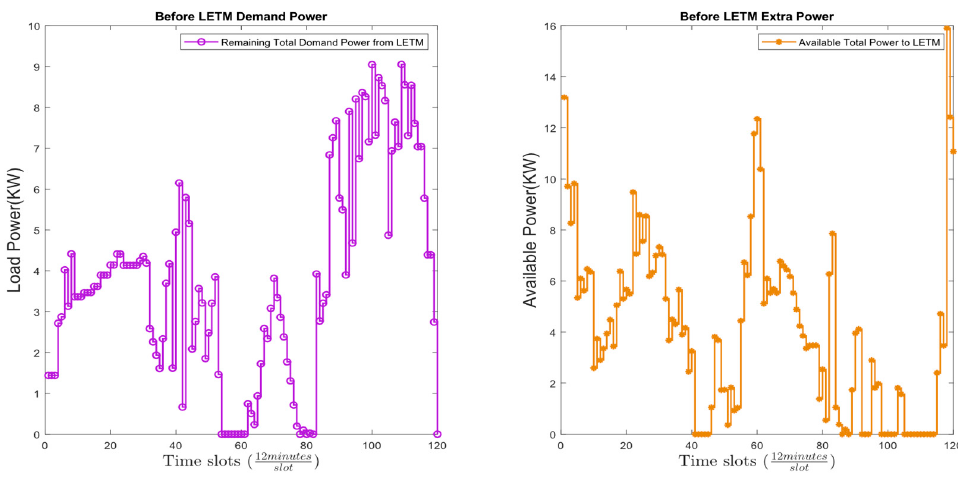
Figure 19. Power demand and surplus before LETM for scheduled load.